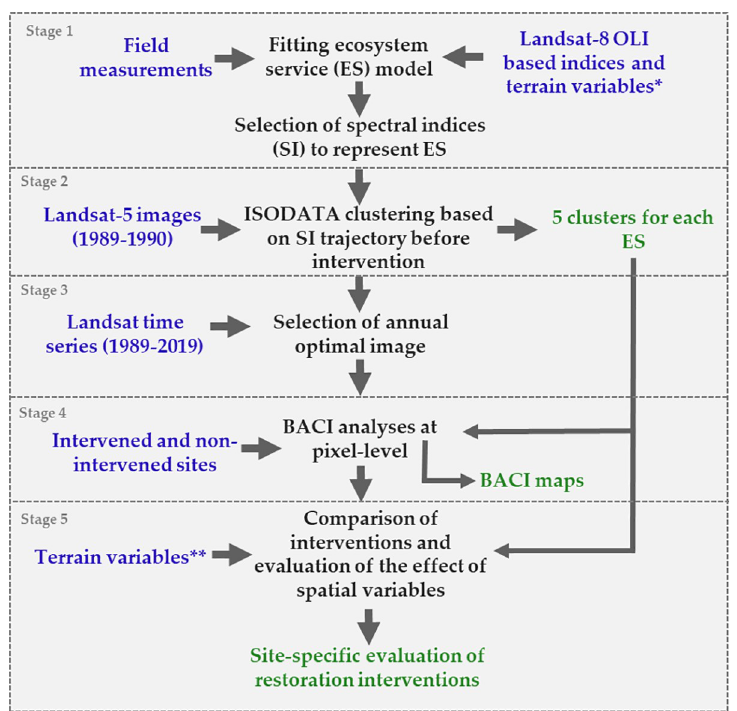
Fig 2. Workflow diagram. The methodological steps are referred to as stages (in grey). Blue colors indicate input data; black shows processes and analyses; green corresponds to output data. � In stage 1 we used slope and altitude. �� In stage 5 we used slope and altitude in the correlation analyses, and aspect and soil parent material for the nonparametric test.